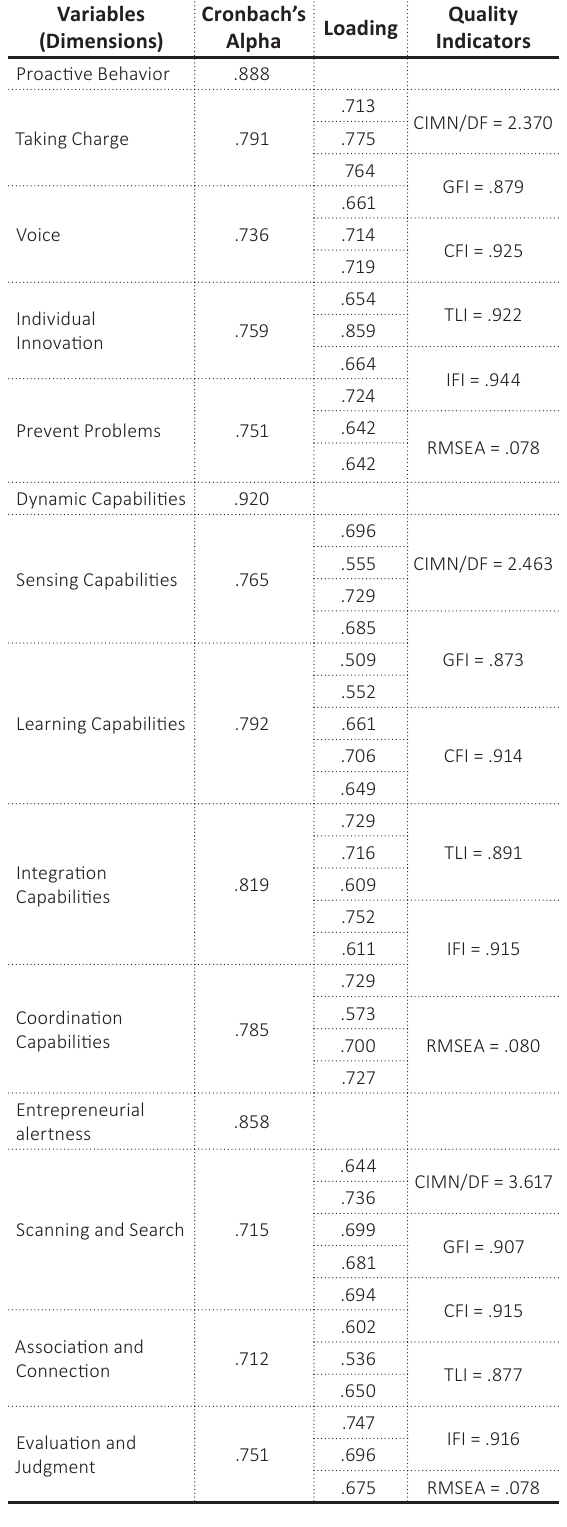
Table 2. Confirmatory factor analysis and Cronbach’s alpha